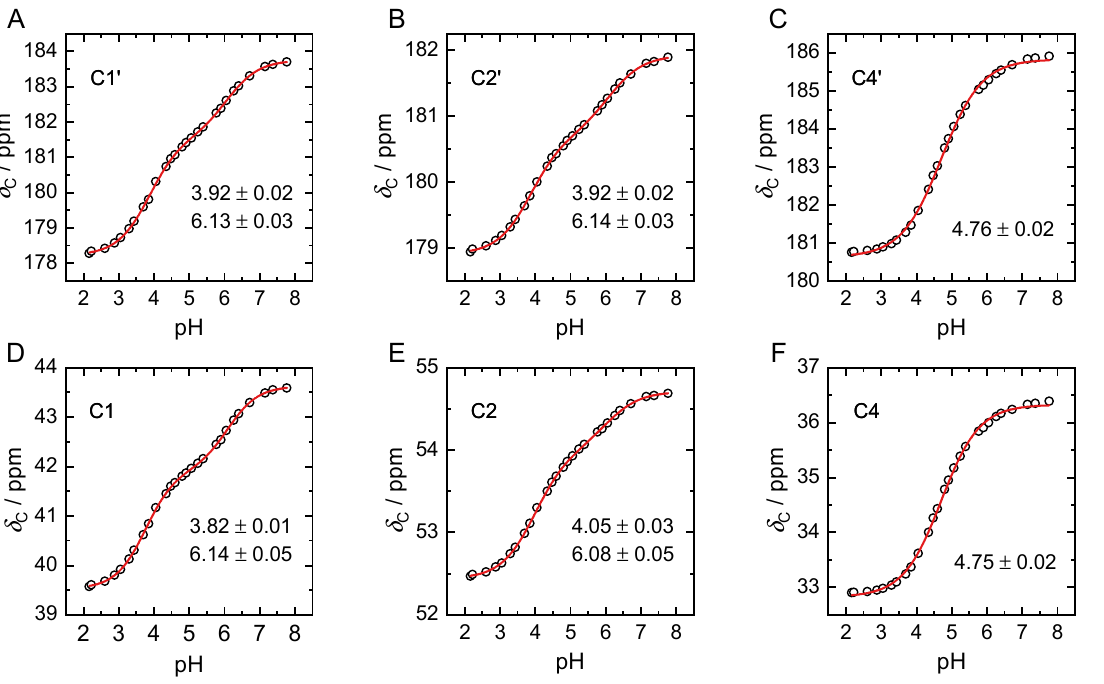
Figure 2. Graphs of pH-dependent 13 C NMR chemical shift values (black circles) obtained from pH-titration series of 25 mM PBTC in 0.5 molal NaCl solutions. Graphs respectively correspond to carboxyl carbons C1’ ( A ), C2’ ( B ), C4’ ( C ), and methylene carbons C1 ( D ), C2 ( E ), C4 ( F ). The p K a values obtained from sigmoidal (bi-)dose–response fits (red lines) are stated with each subfigure.